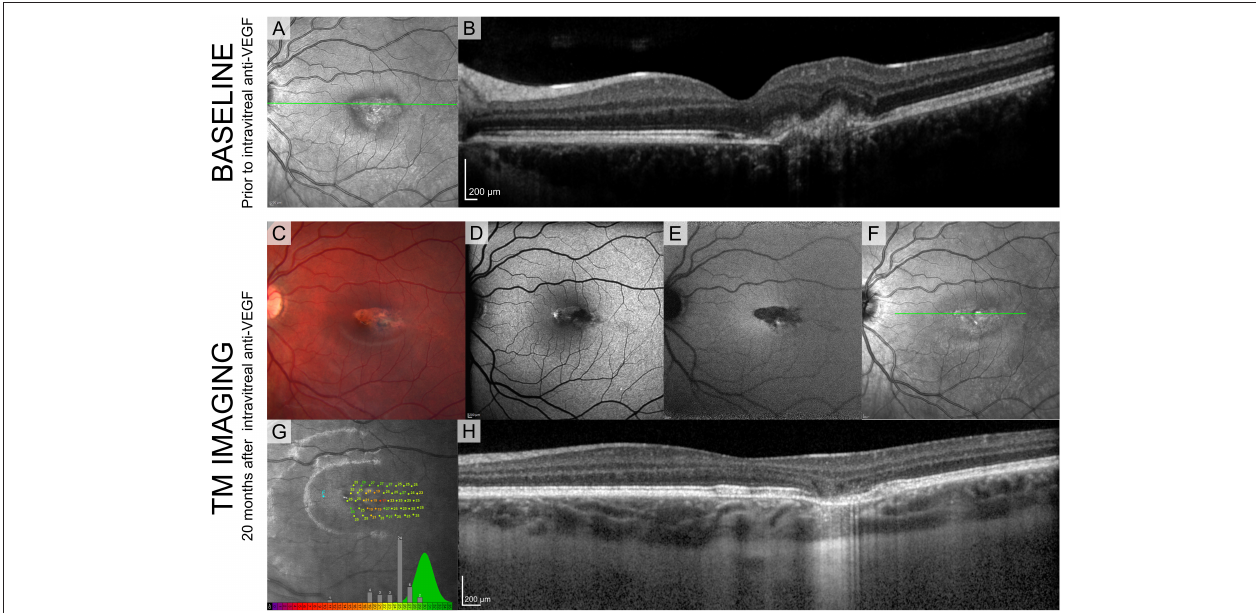
FIGURE 4 | Standard clinical imaging of patient 2. (A,B) SLO reflectance image and OCT B-scan taken from the location marked with a green line before the injection. (C) Fundus photograph 20 months after the injection. (D-F) SLO images from Spectralis (BAF, IRAF, reflectance) showing reduced FAF signal from the lesion. (G) Sensitivity estimates from MAIA show decreased values but compared to patient 1 they are substantially higher, suggesting intact visual sensitivity within the lesion. Green distribution represents normative data from the manufacturer’s database. (H) OCT B-scan taken from the location marked with a green line in (D) .